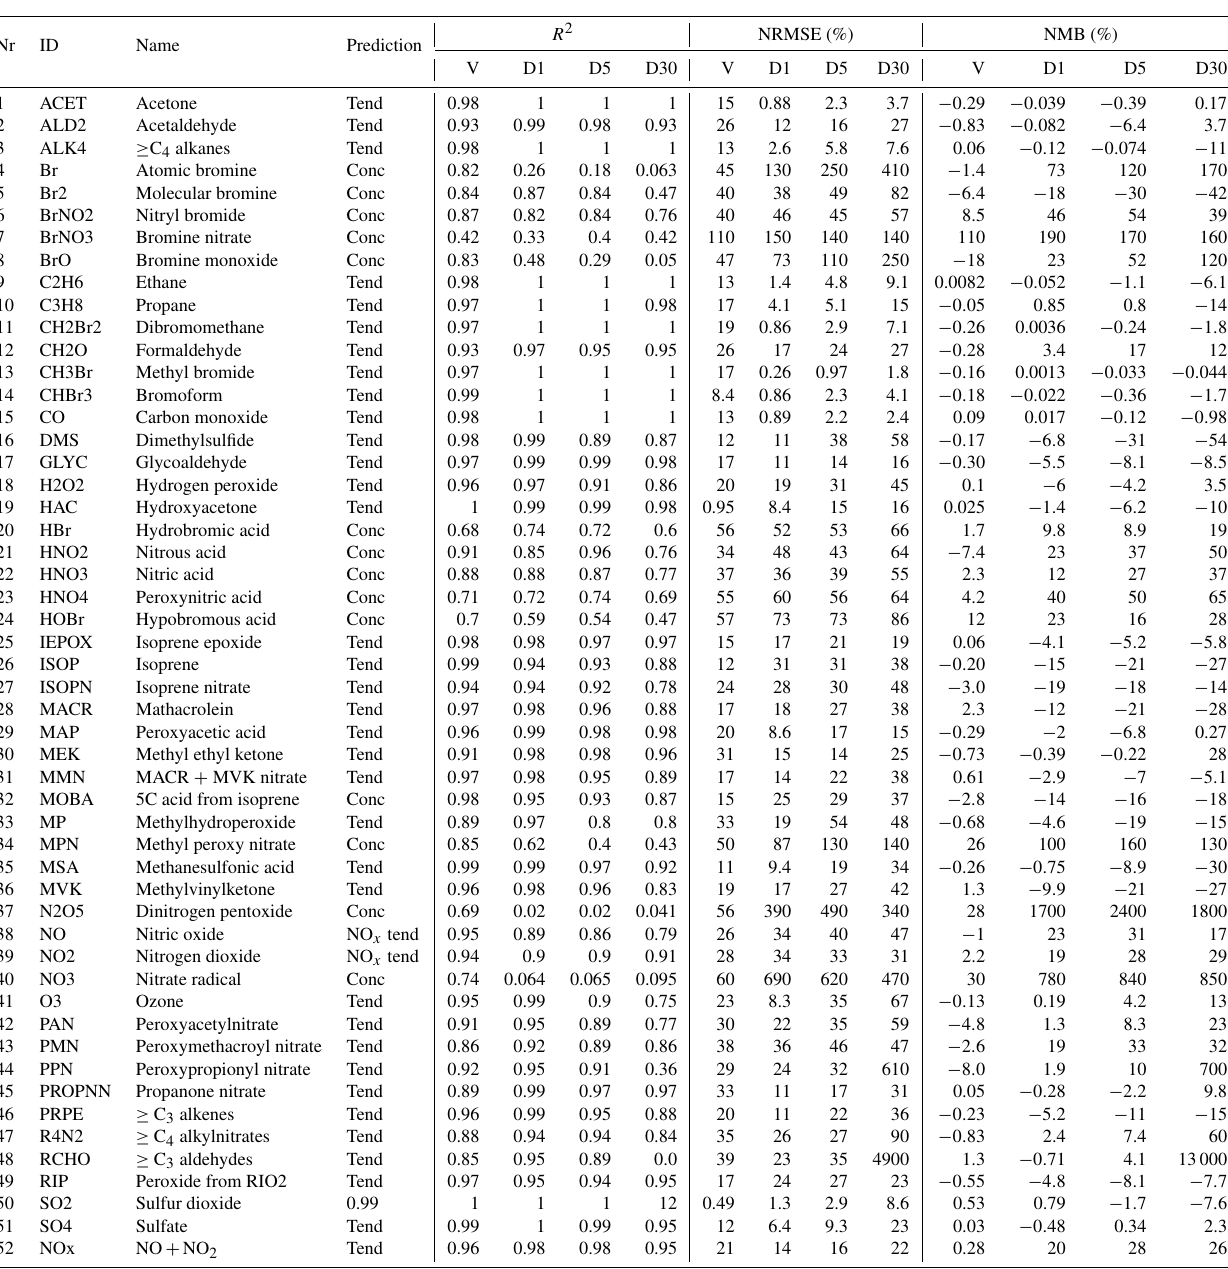
Table 1. Overview of the performance of the RFR model with the NO x family treatment. Shown are the Pearson correlation R 2 , normalized root mean square error (NRMSE) and normalized mean bias (NMB). Comparison against the validation data set (10% of training data withheld from training) are indicated with a “V”. Comparisons between the RFR simulation and the full GEOS-Chem model for July 2014 at 00:00UTC after the 1st, 5th and 30st simulation day are indicated with “D1”, “D5” and “D30”, respectively. Prediction type of each species (concentration, tendency, NO x family treatment) is given in the prediction